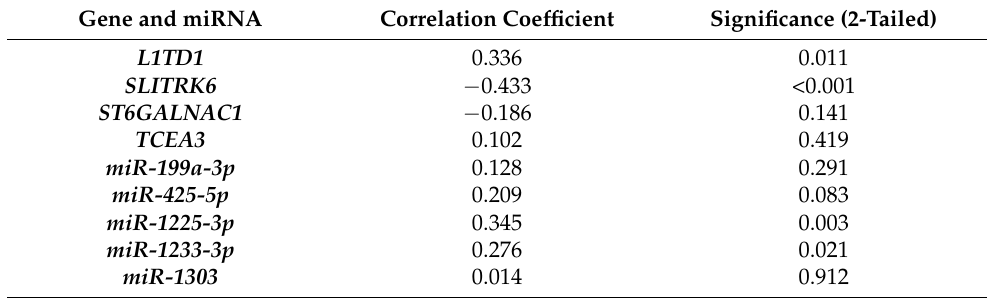
Table 5. Spearman correlation coefficients of the association between ∆ Cq of analysed genes and miRNAs and level of malignancy (from normal mucosa to adenoma, adenoma with early carcinoma, carcinoma without and carcinoma with lymph node metastases). Gene and miRNA Correlation Coefficient Significance